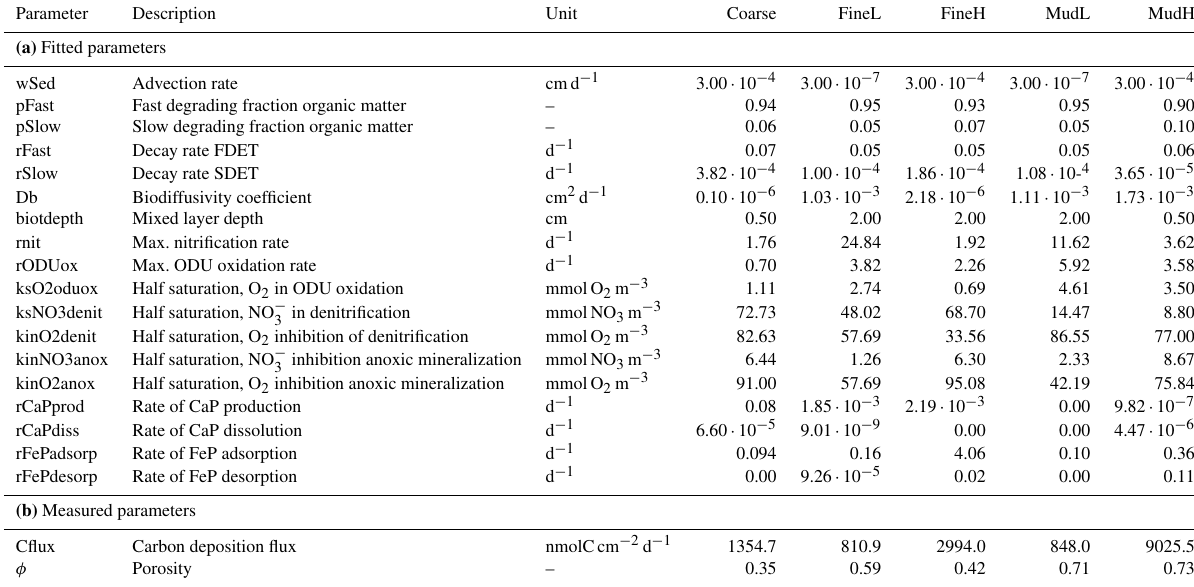
Table 3. Parameters used for modelling the different sediment types.